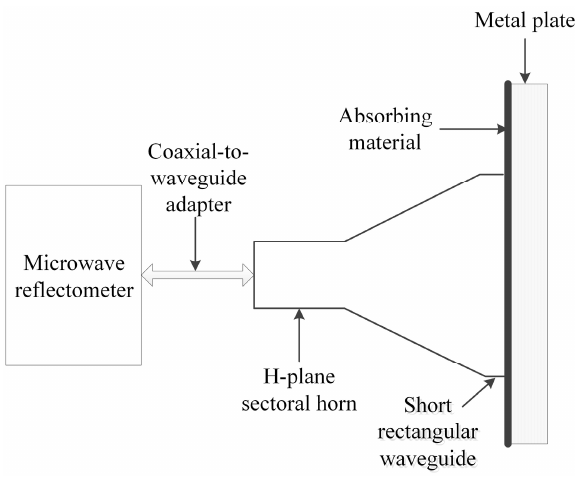
Figure 3. Schematic diagram of the testing system.